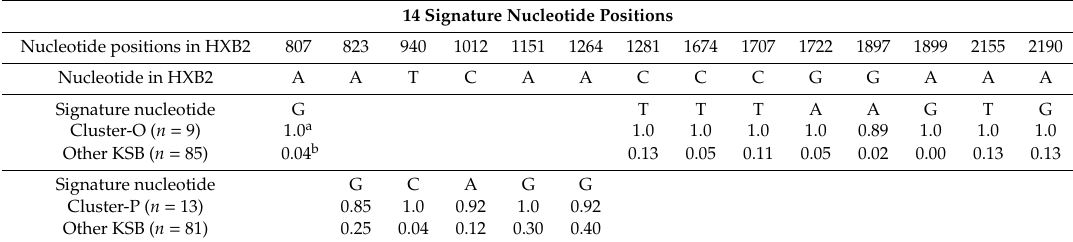
Table 1. Frequency of the signature pattern nucleotides in the gag gene in 94 KSB-infected patients. 14 Signature Nucleotide